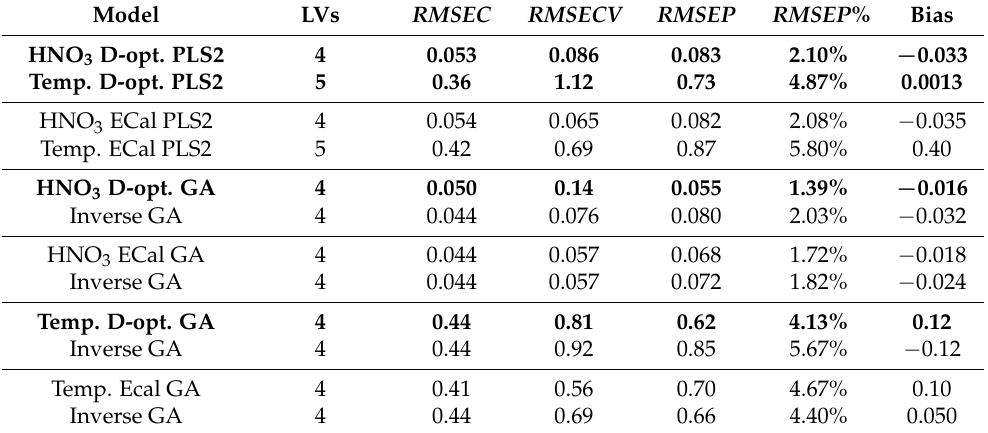
Table 2. Model calibration and validation